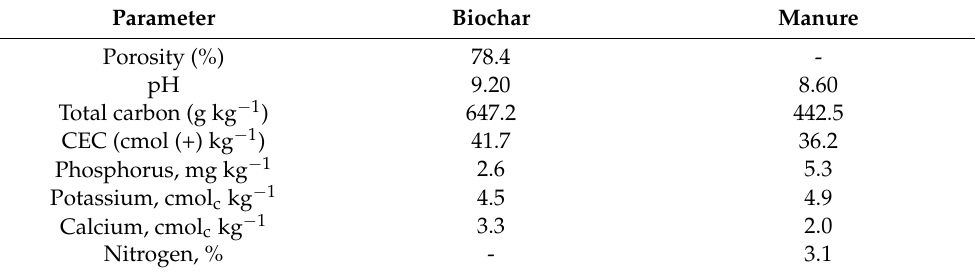
Table 2. Selected chemical characteristics of the biochar and manure used in the test. Parameter Biochar Manure Porosity